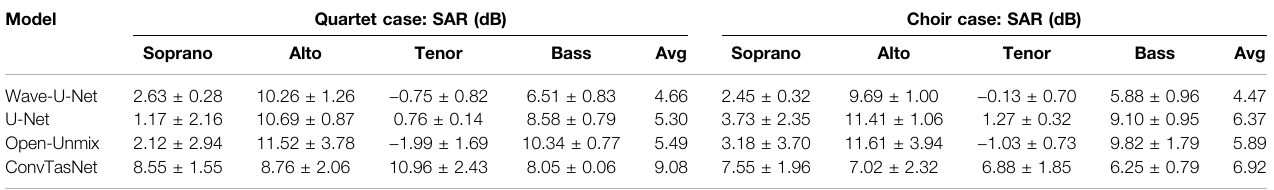
TABLE6| SARresultsfrom modelname_CBDE evaluatedonECDsongs(13singerswithallthesingersinthemix),showingthetrainingwithdatafromthequartetcase(left) and choir case (right). Model